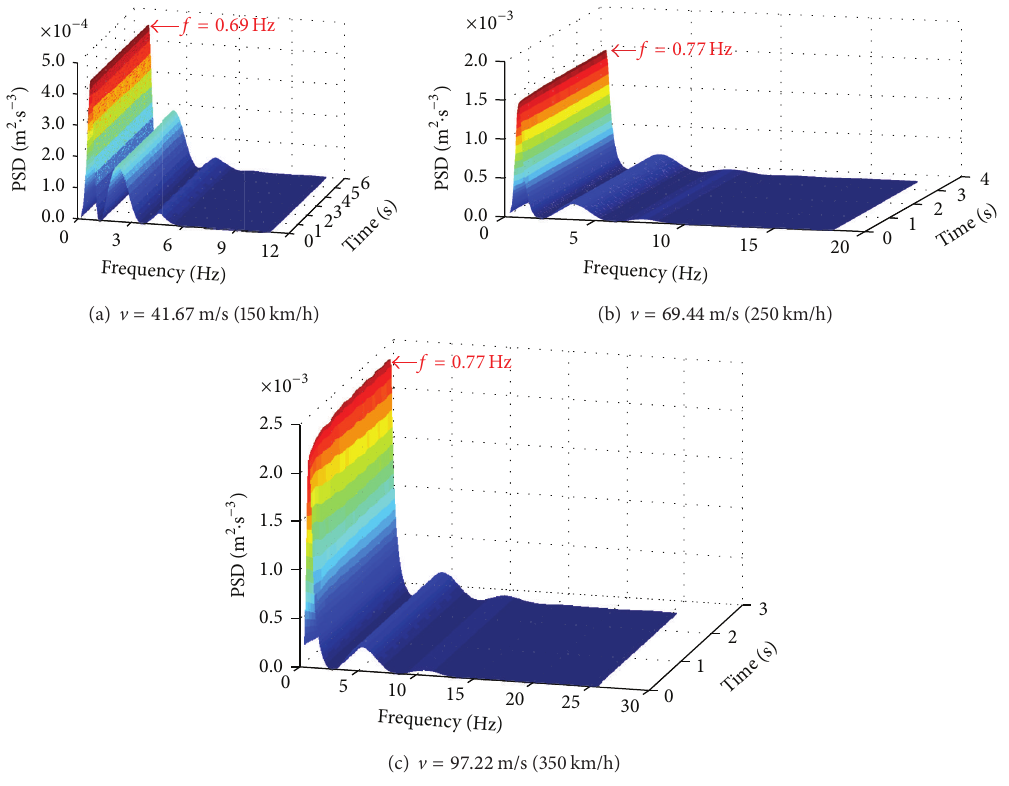
Figure 22: PSD of vertical acceleration of trailer